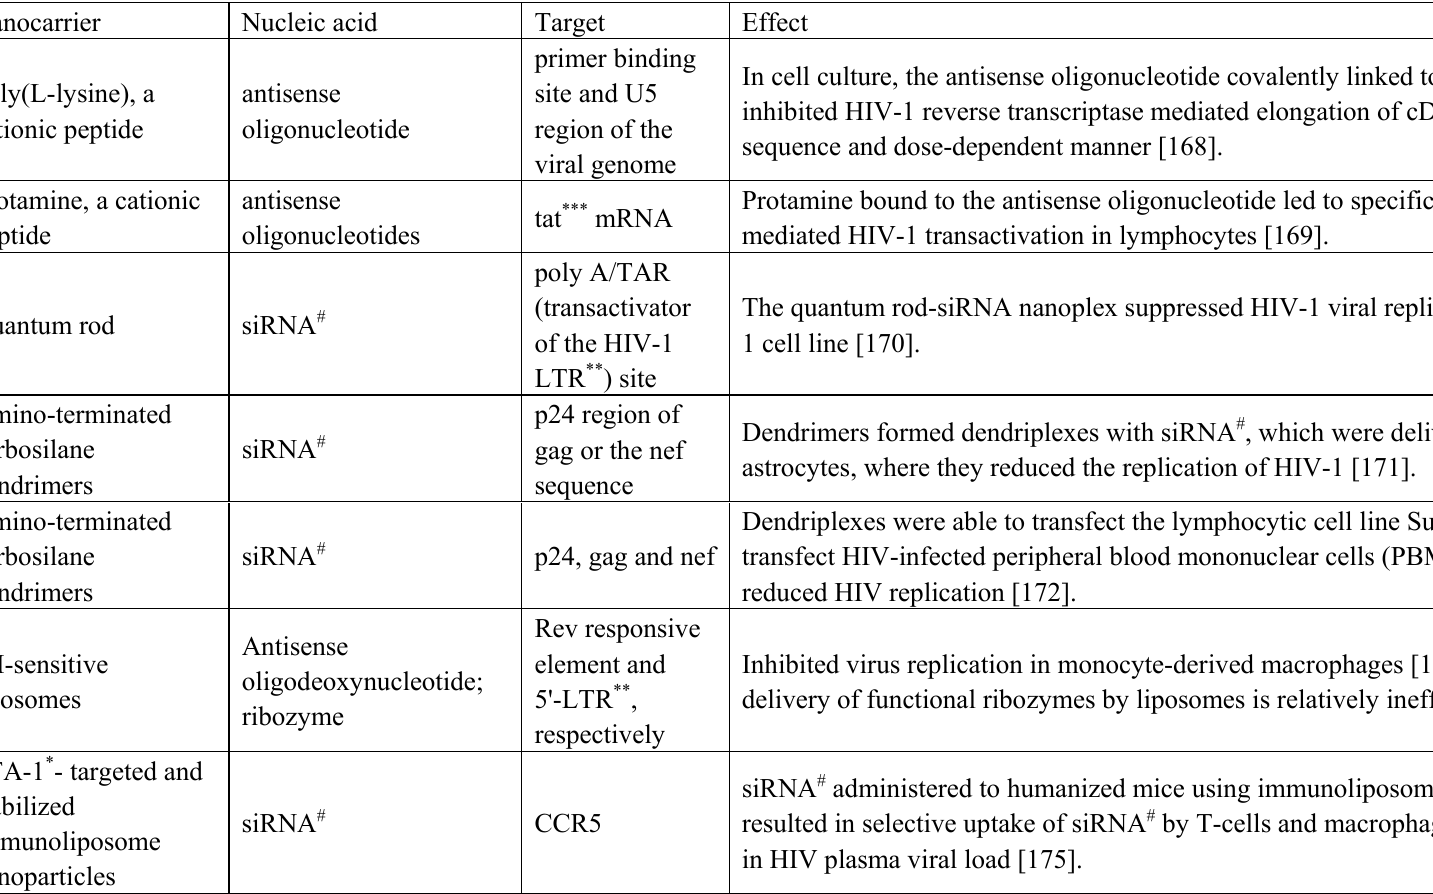
Table 3. Potential anti-HIV nucleic acids and their delivery by